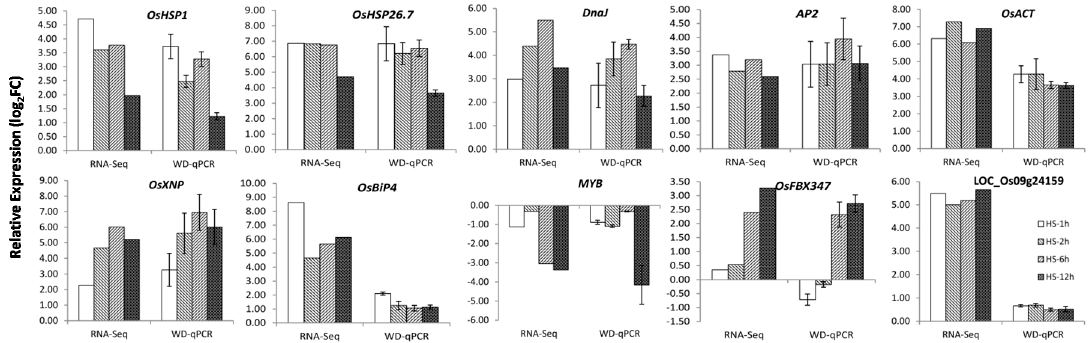
Figure 5. Expression levels of ten randomly selected DEGs by RNA-seq and qRT-PCR. RNA-seq: expression change of these genes in anthers of SDWG005 under heat treatments as compared to control by RNA-seq. WD-qPCR: expression change of these genes in anthers of SDWG005 under heat treatments as compared to control by real-time PCR.